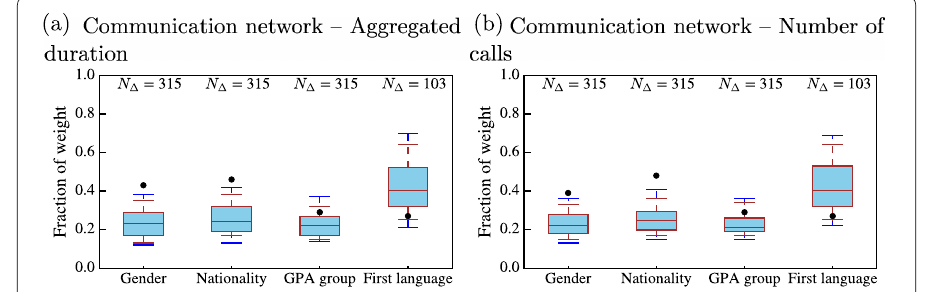
Figure 10 Triadic homophily—yearly-aggregated communication network. Data (black dots) are compared with the distribution (boxplots) obtained for a null model in which attributes are reshuffled among nodes. N (cid:2) gives the number of triads on which the statistics is made. Boxplot: Whiskers—5th, 10th and 90th, 95th percentiles; box—25th and 75th